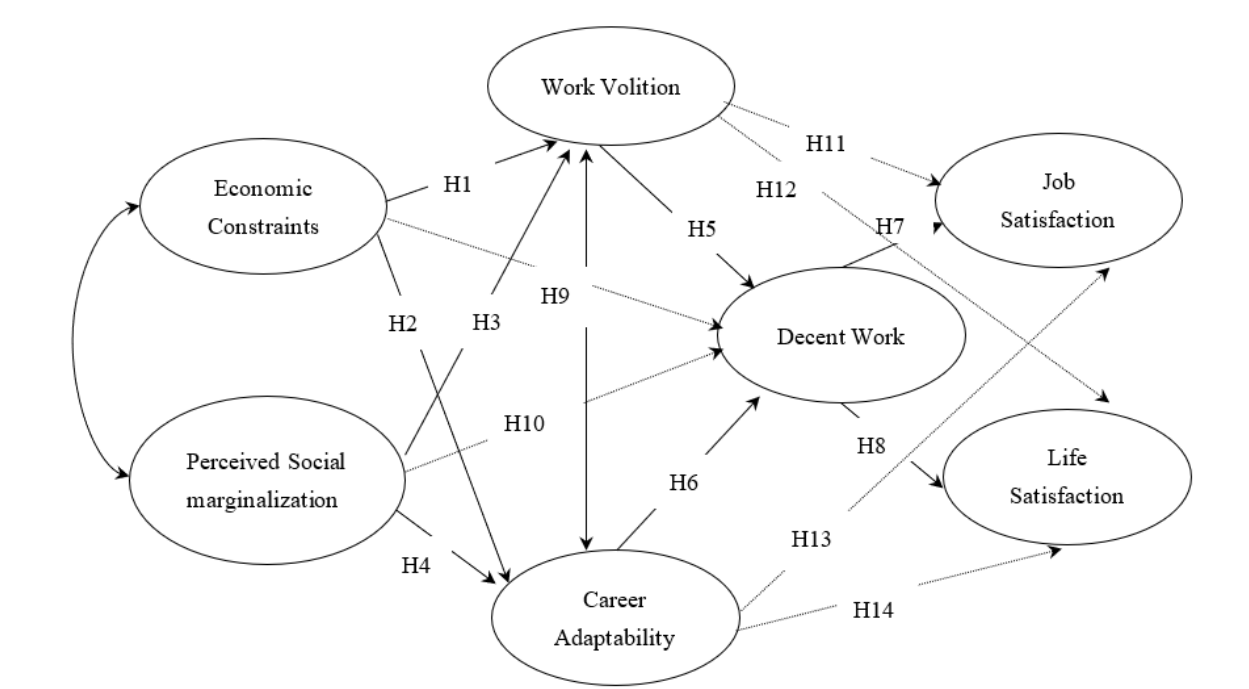
Figure 1. The hypothesized model. Note. Although not assumed in the PWT model, the paths added in this study are indicated by dashes. Age, education, and working period were